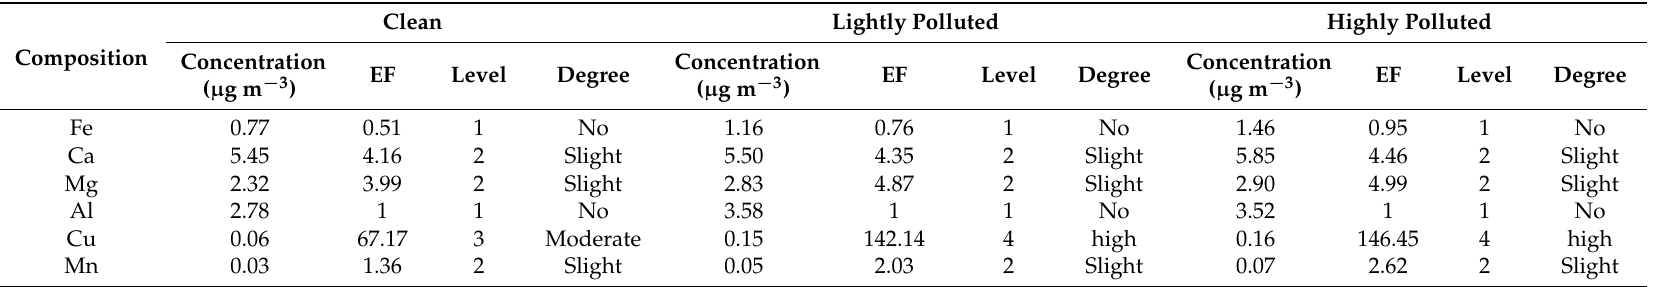
Table 4. Average enrichment factor (EF) of elements in PM 2.5 at different PM 2.5 pollution